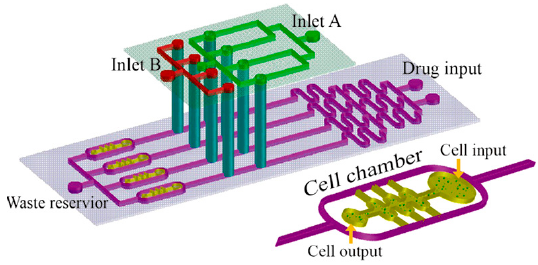
Figure 6 . Schematic of the multi-layer microfluidic device applied to investigation the chemoresistance of cancer cells